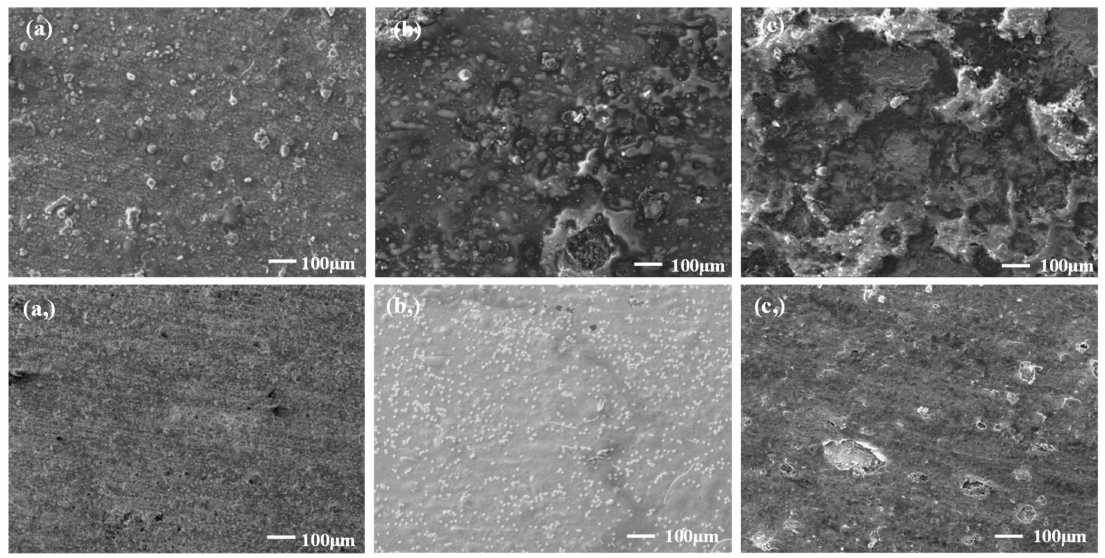
Figure 8. Micromorphology of corrosion inhibitor films on the surface of 2205 duplex stainless steel sample at 100 × magnification (( a ) 140 ◦ C the outer film, ( a, ) 140 ◦ C the inner film, ( b ) 160 ◦ C outer film, ( b, ) 160 ◦ C the inner film, ( c ) 180 ◦ C outer film, ( c, ) 180 ◦ C the inner